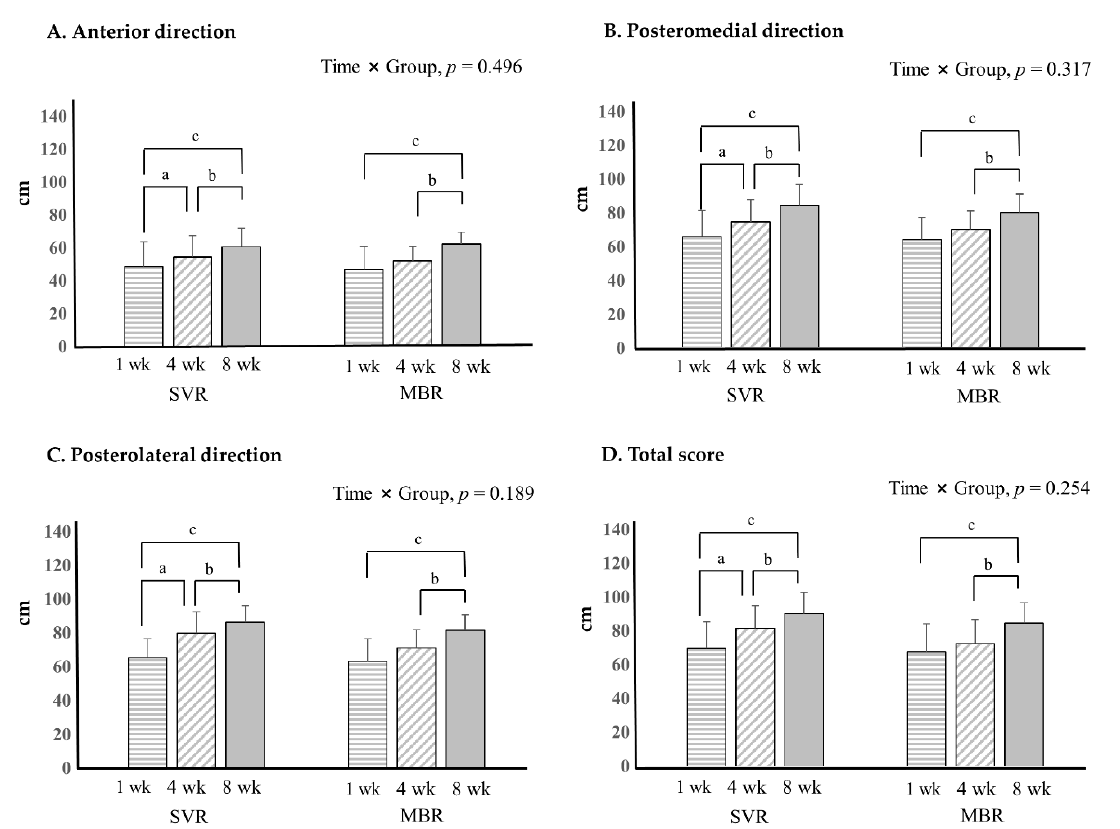
Figure 5. Dynamic balance with Y–balance test. p < 0.05; significance, a = 1 week versus 4 weeks; b = 4 weeks versus 8 weeks; c = 1 week versus 8 weeks. Abbreviations: SVR, supervised rehabilitation; MBR, mobile-based rehabilitation, wk; week.